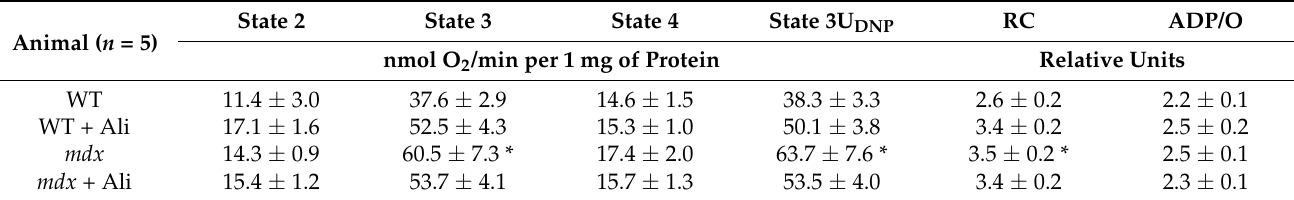
Table 3. Effect of alisporivir on the parameters of respiration and oxidative phosphorylation of heart mitochondria of studied groups of